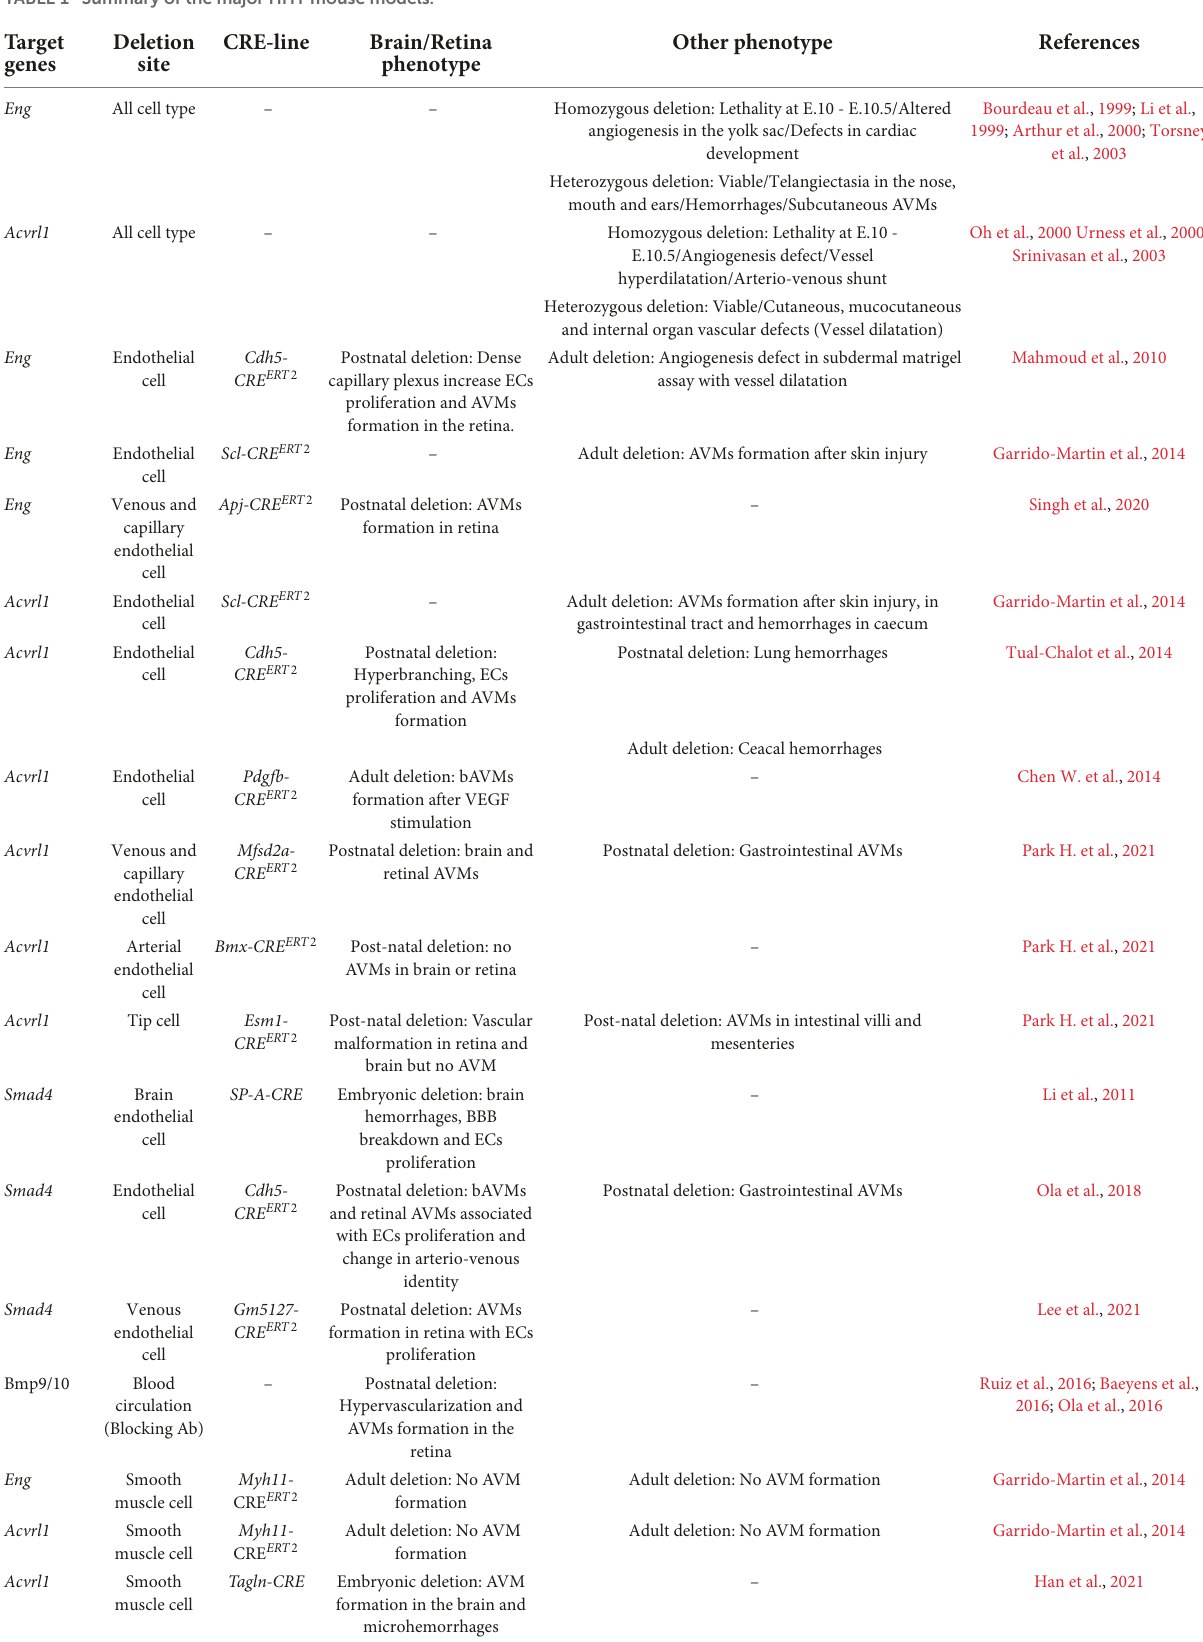
TABLE 1 Summary of the major HHT mouse